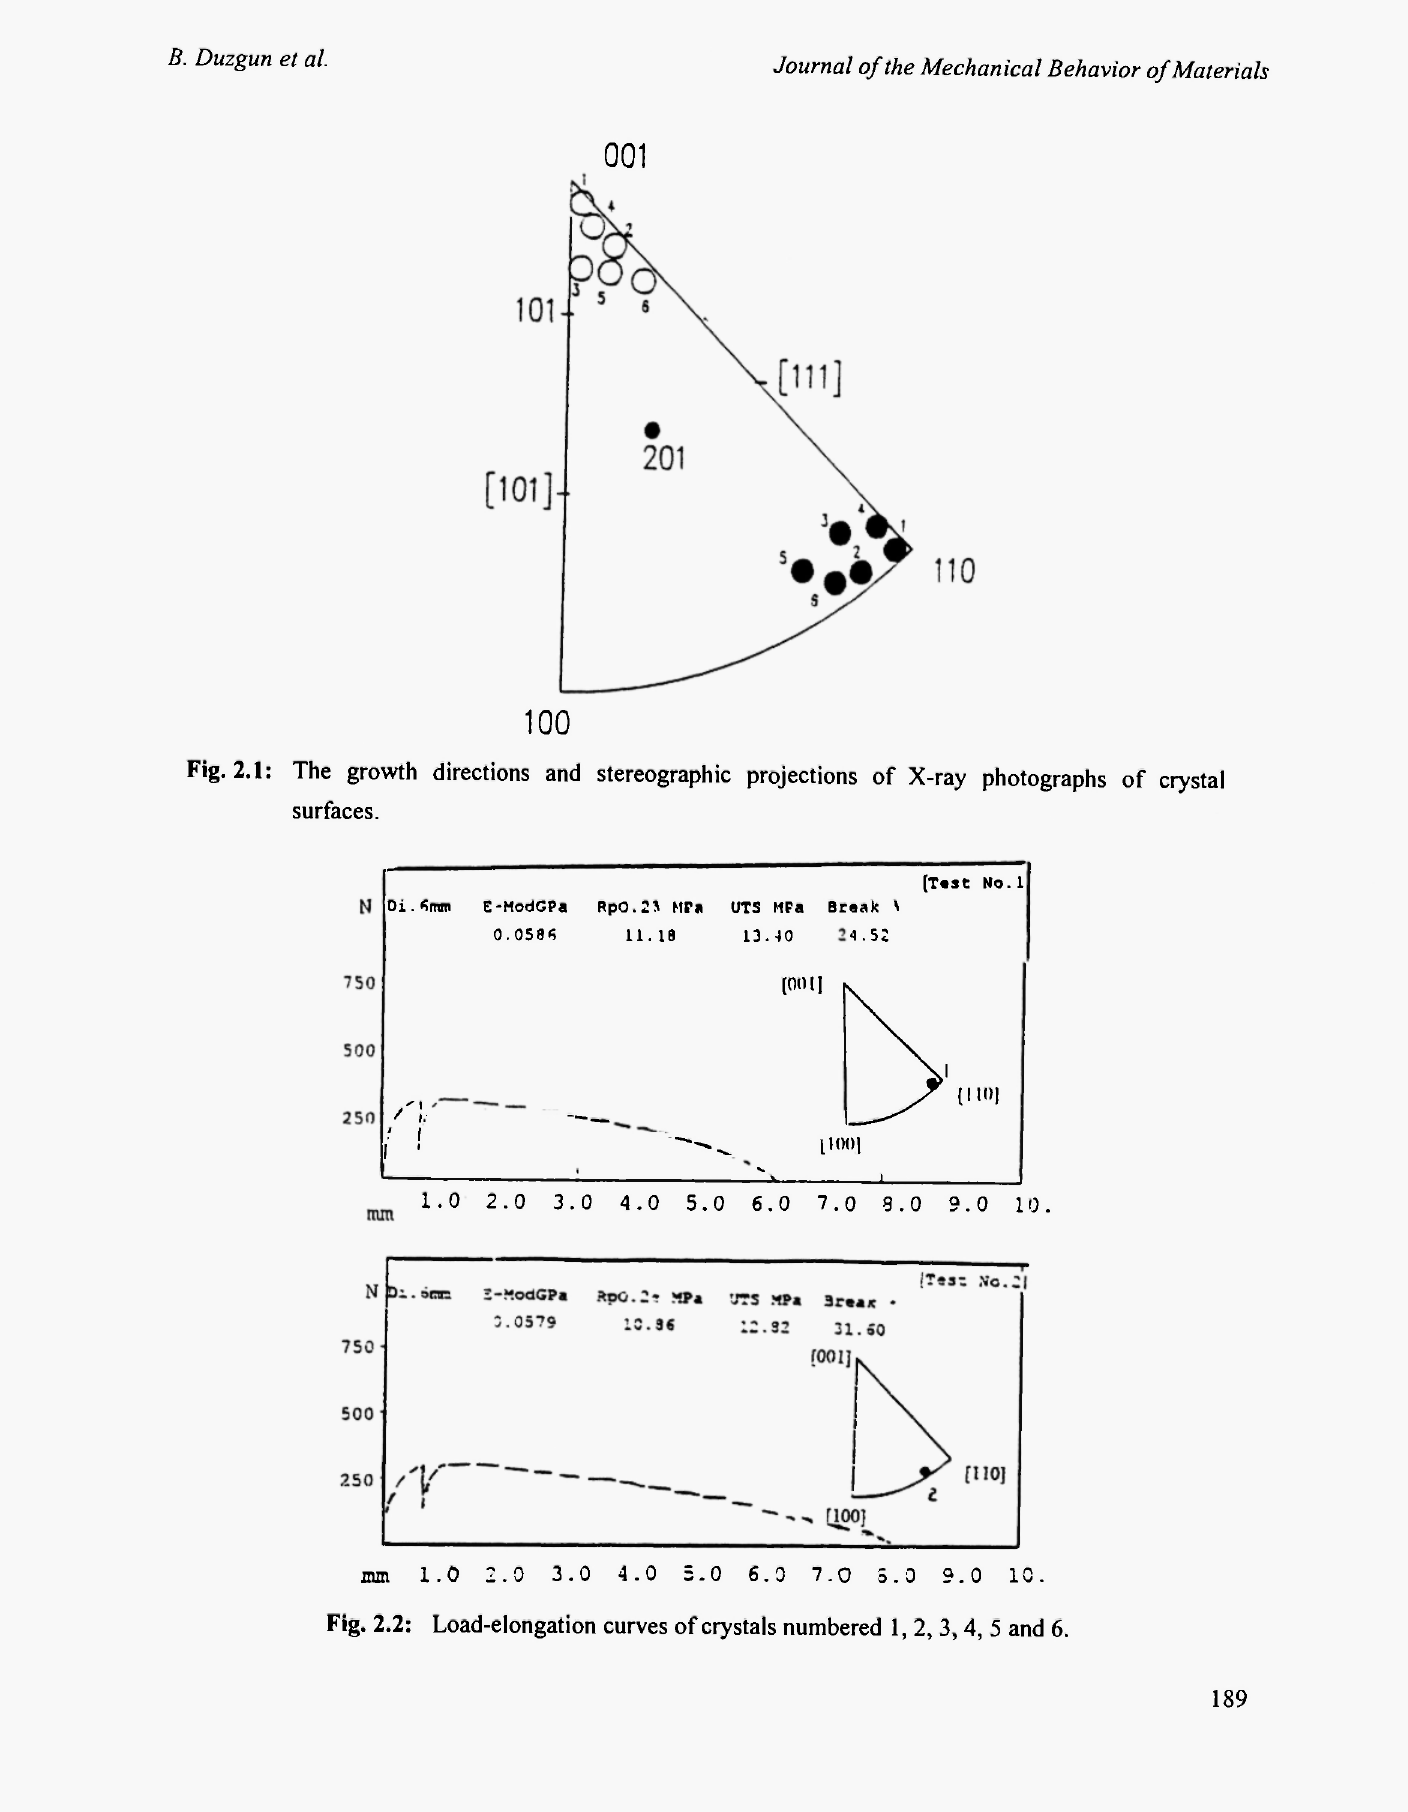
Fig. 2.2: Load-elongation curves of crystals numbered 1 , 2, 3, 4, 5 and